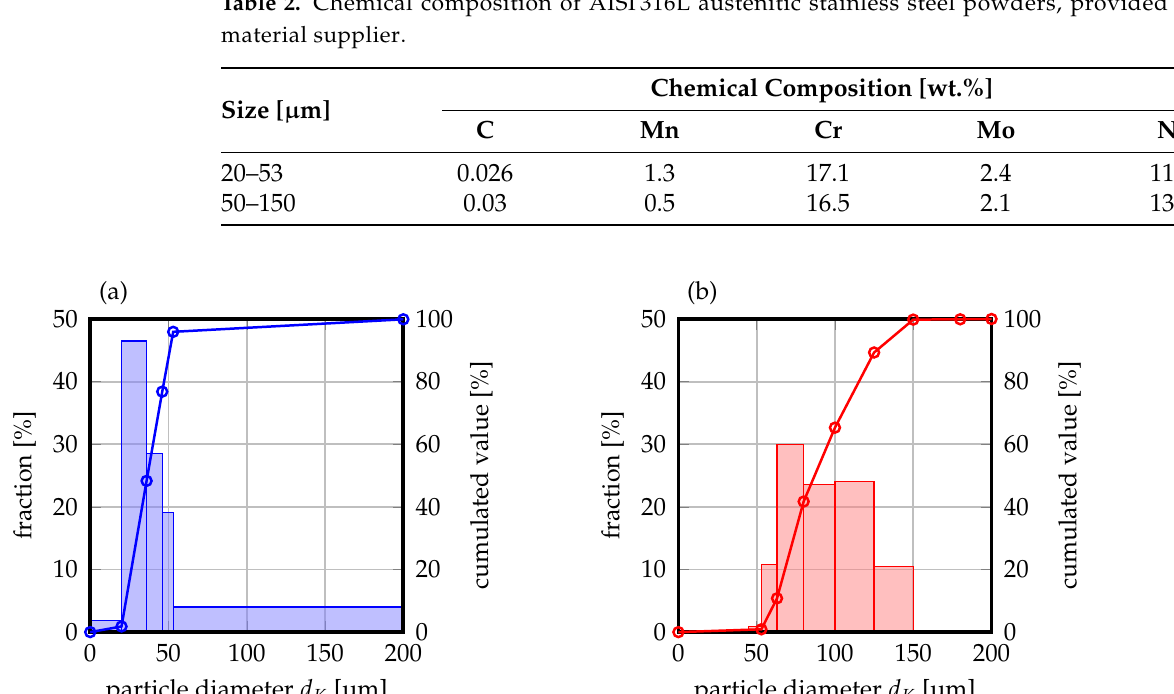
Figure 1. Particle size distribution of the two powder batches used in the present investigation. Nominal distribution: ( a ) 20–53µm, ( b ) 50–150µm, as provided by the material